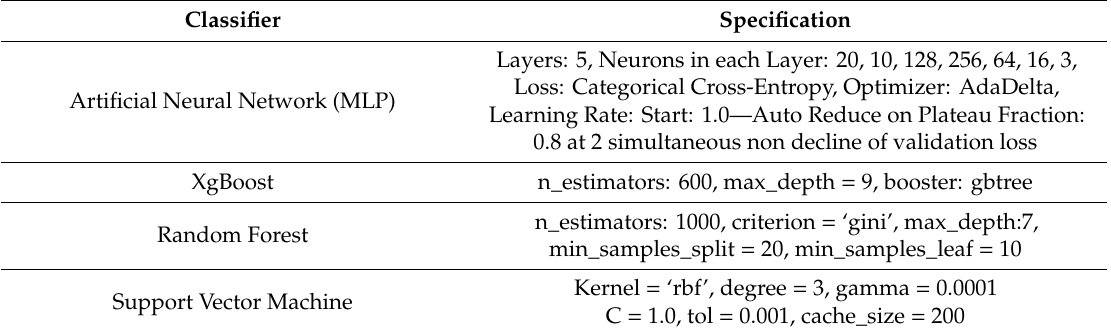
Table 8. Classifier Hyperparameters.